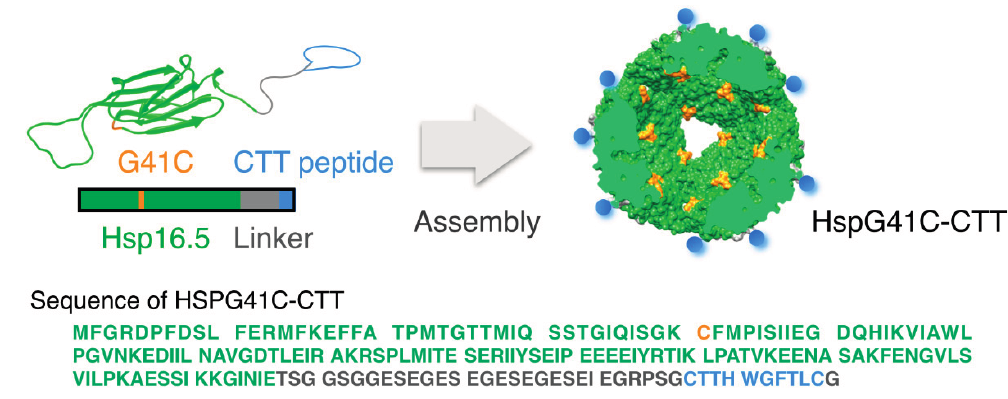
Figure 1. Schematic representation and sequence of the engineered HspG41C-CTT protein nanocage. Blue and gray regions indicate the CTT peptide and hydrophilic linker, respectively. The orange region indicates the Gly residue at position 41, which was mutated to a Cys residue for conjugation to the near-infrared (NIR) fluorophore